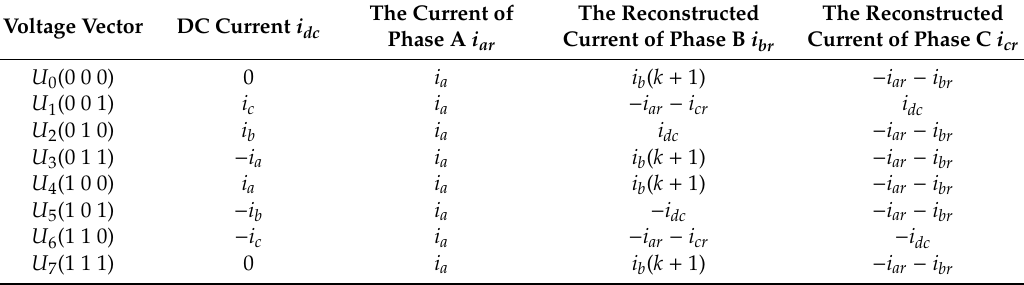
Figure 5. Current flow for eight different voltage vectors. Table 1. Current relationship and reconstructed current under eight voltage